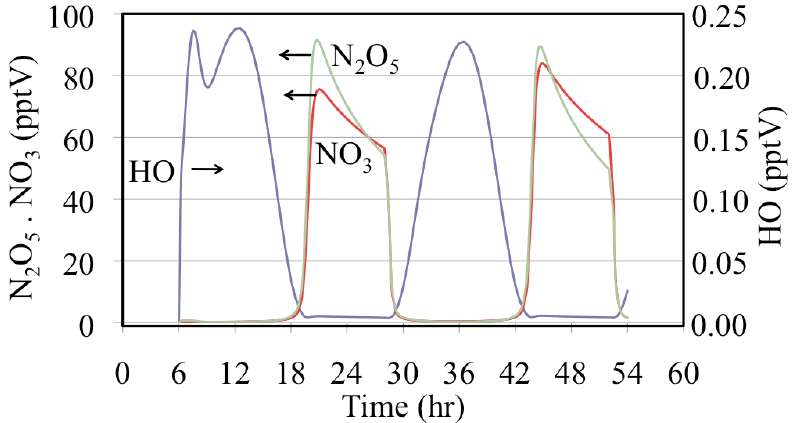
Figure 16. Hydroxyl radical, nitrate radical and dinitrogen pentoxide mixing ratios are shown for the polluted urban atmosphere